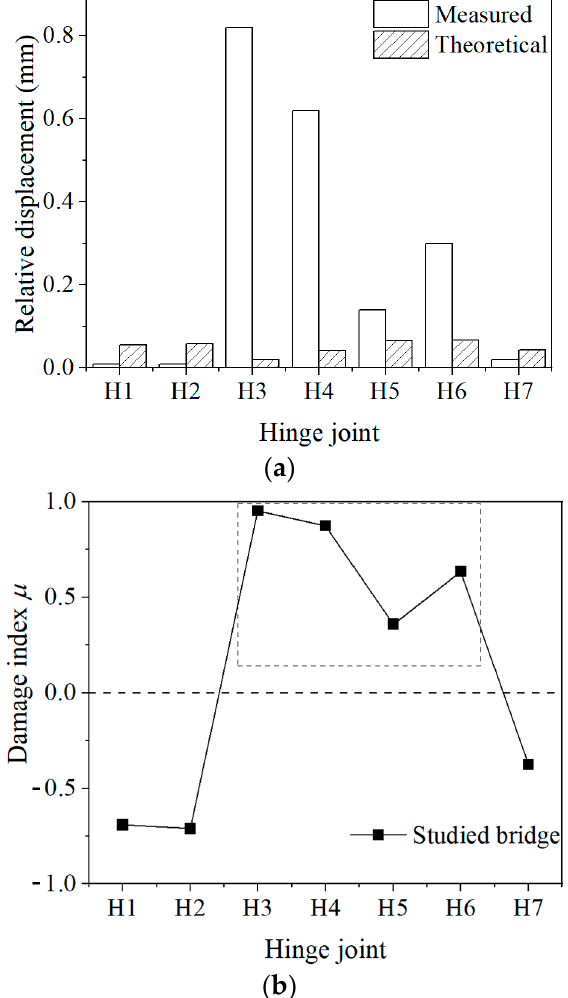
Figure 10. Hinge joint: ( a ) relative displacement; ( b ) damage index µ.